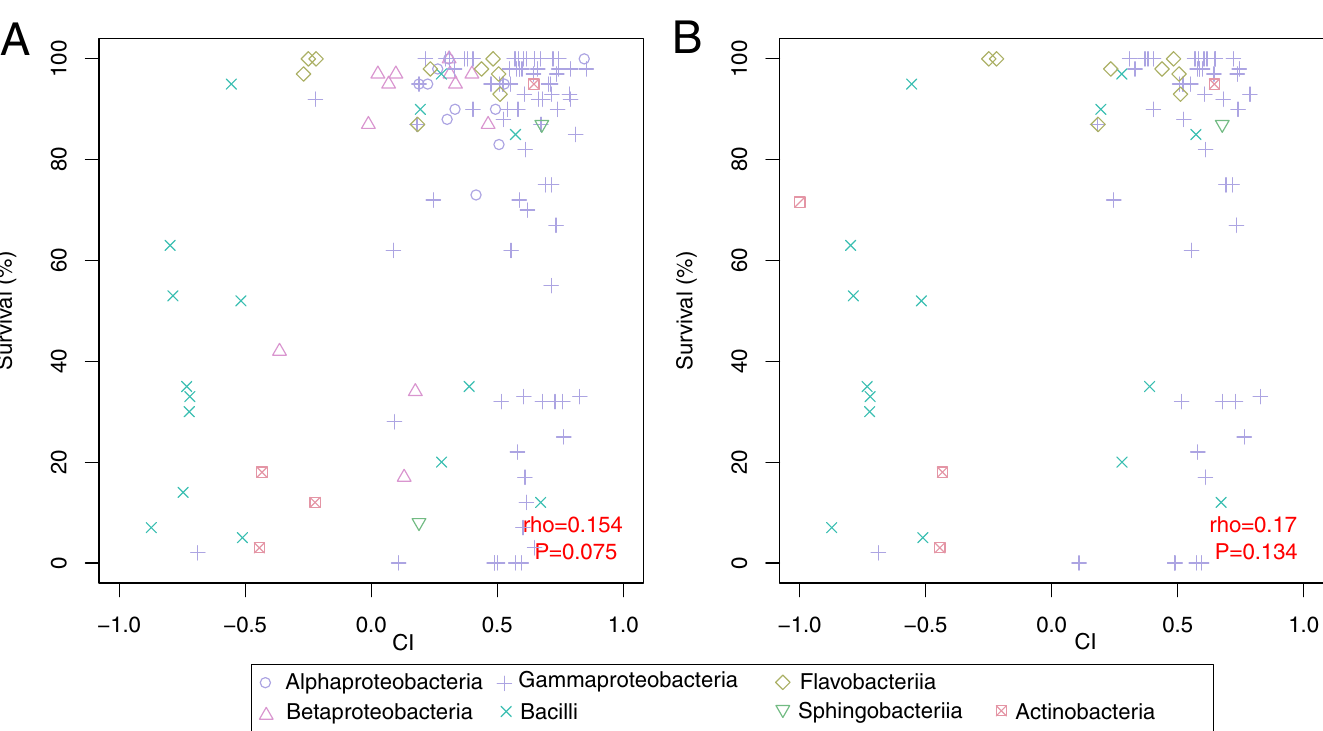
PLOS ONE | https://doi.org/10.1371/journal.pone.0198018 June 4,